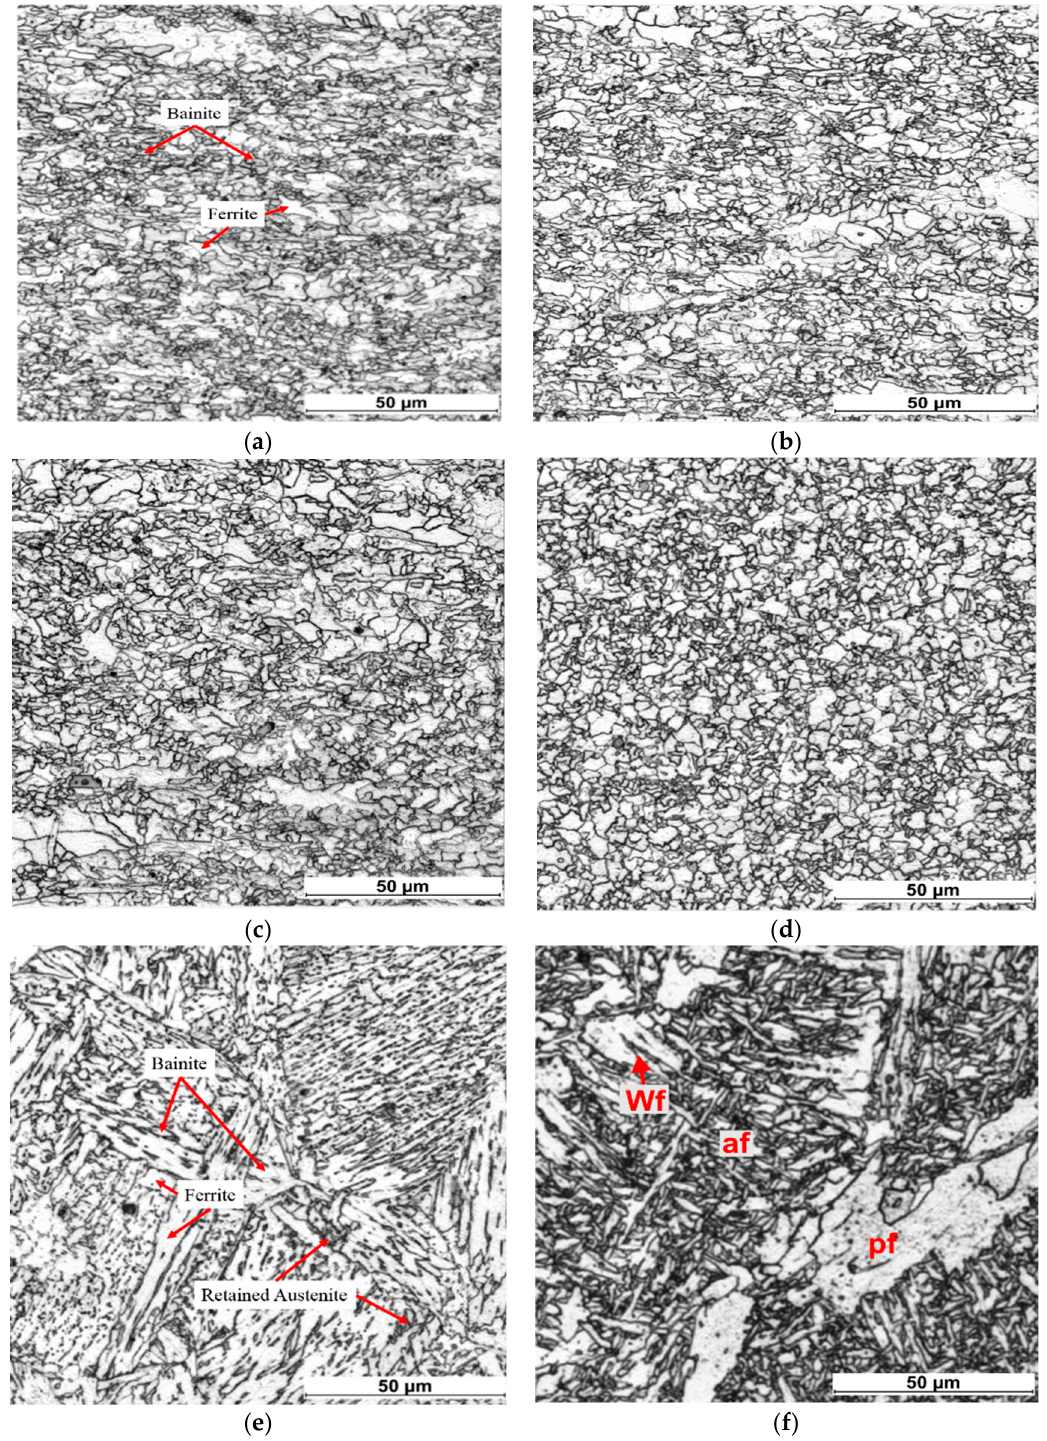
Figure 10. The microstructure of the thermo-mechanically controlled process (TMCP) steel welded joint with the second welding condition: ( a ) base metal; ( b ) SCHAZ, ( c ) ICHAZ; ( d ) FGHAZ; ( e ) CGHAZ; ( f ) weld metal (Wf—Widmanstätten ferrite; af—acicular ferrite; pf—polygonal ferrite).